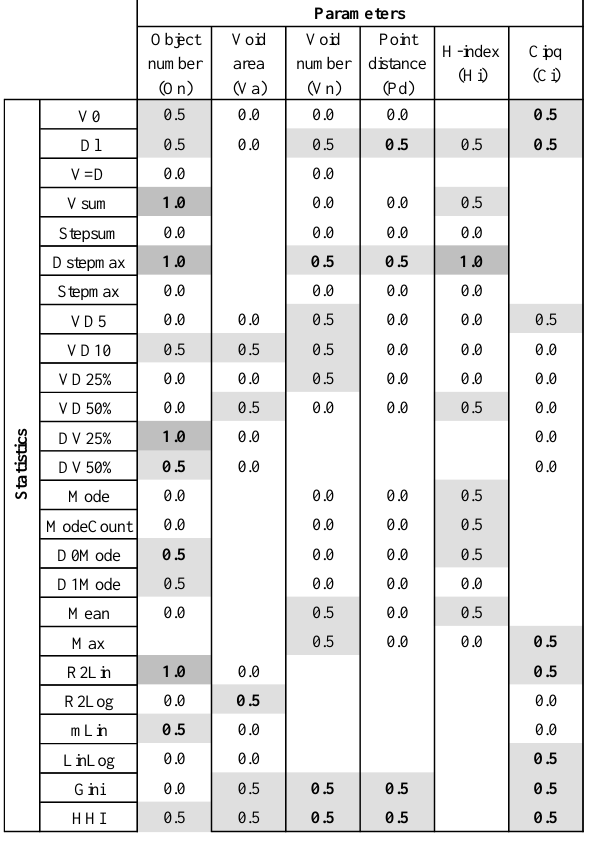
Table 5 . Combinations of parameters and statistics used to calculate the features and their average selection rate for Random full and Milan sets. Milan features are bold.